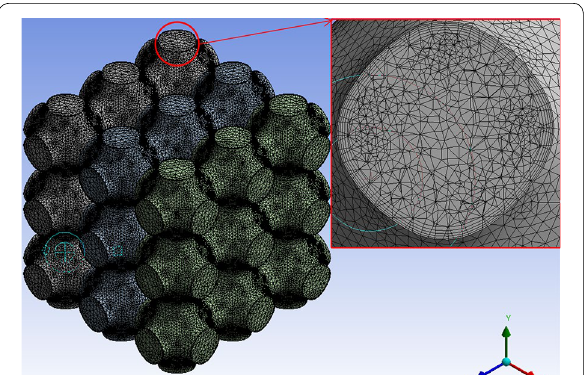
Figure 3 Mesh models of bone scaffolds in the CFD software